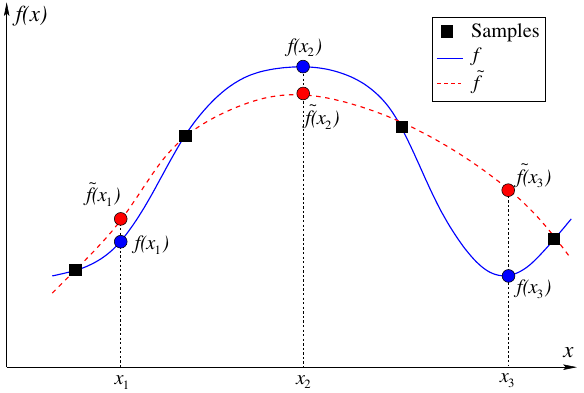
Figure 6. Selection Error Probability (SEP) concept is